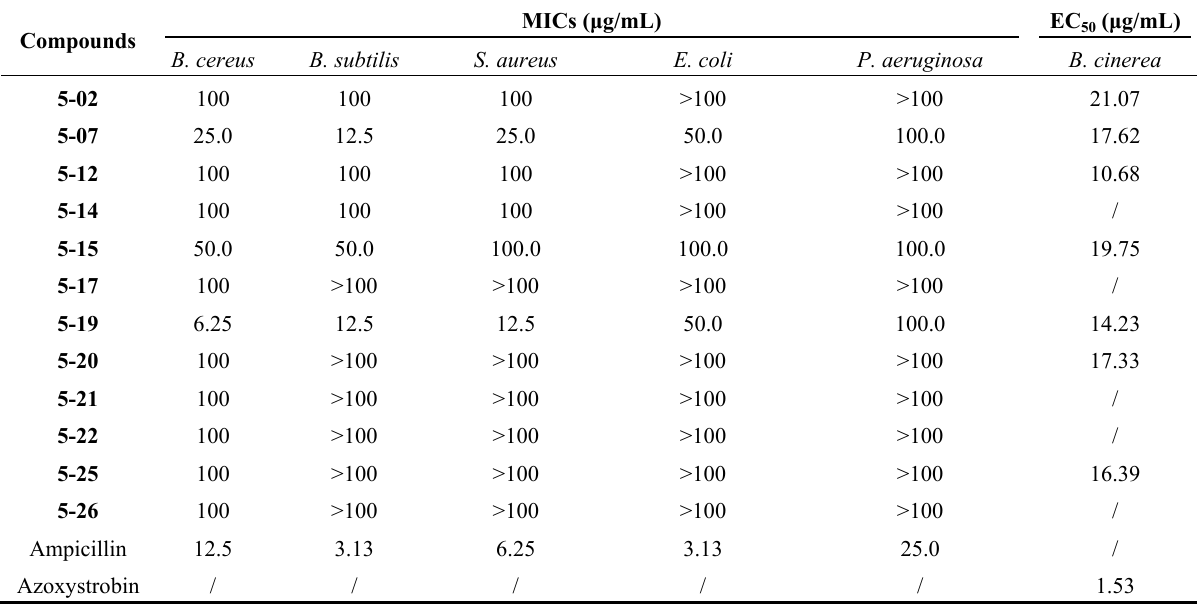
Table 2. Minimum inhibitory concentrations (MICs) and 50% effect concentrations (EC of title compounds against standard